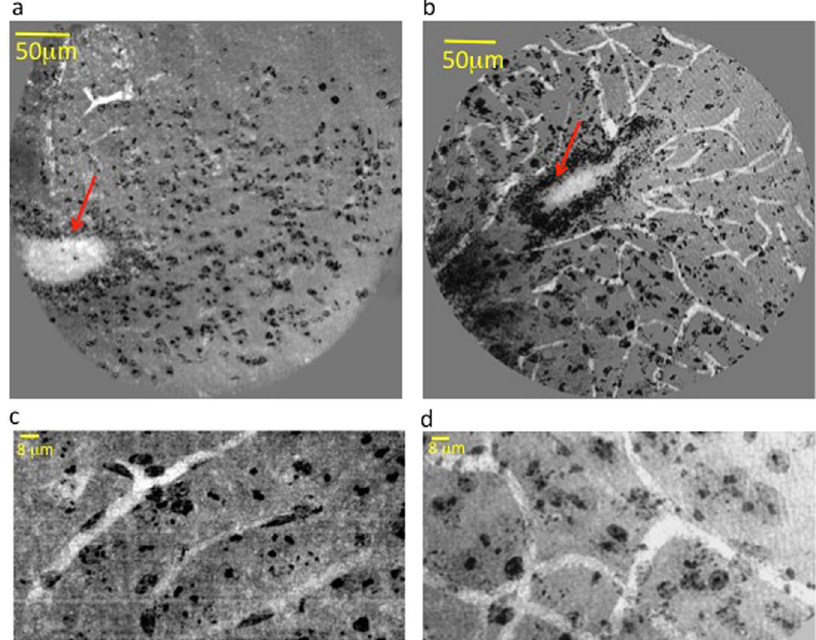
Figure 4. Nano-XPCT of the capillary network in spinal cord of EAE-affected mice treated or not with MSC. Axial view of the capillary network (rendered in white) and cell population (rendered in black) in untreated ( a , c ) and MSC-treated ( b , d ) EAE-affected mice. ( c , d ) Show magnified details of ( a , b ) respectively. Samples were obtained at 5 dpo.